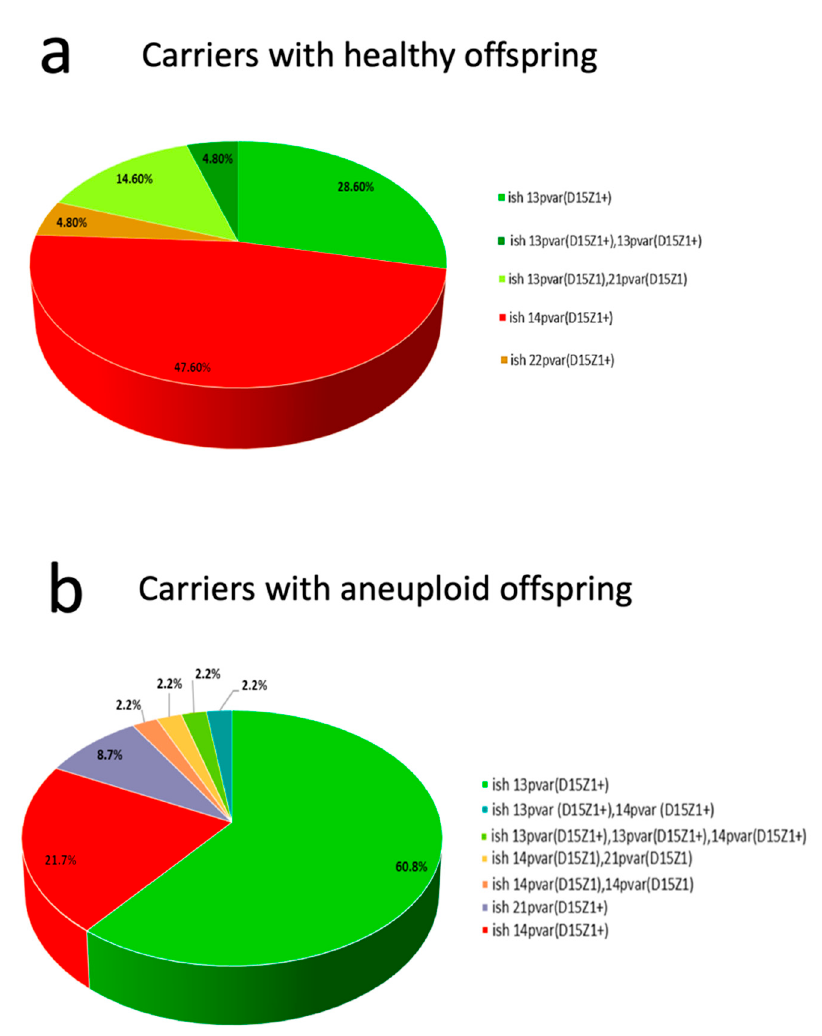
Figure 4. Overview of the frequency and location of the extra D15Z1 signals in carriers of the polymorphism. ( a ) In the carriers within the group with healthy o ff spring, chromosomes 13p, and 14p are the main acceptors of the D15Z1 chromosome region in similar proportion. Note that the proportion of 13p as an acceptor chromosome includes heterozygous, homozygous and compound heterozygous 13pvar(D15Z1 + ), 21pvar(D15Z1 + ) for a total of 48%. ( b ) In the group of individuals with aneuploid o ff spring, chromosome 13p is the main acceptor of D15Z1 with up to 65.2% of all the cases, which includes both heterozygous and homozygous individuals for 13pvar(D15Z1 + ), the 14pvar(D15Z1 + ) reaches 26% taking in account all variants.